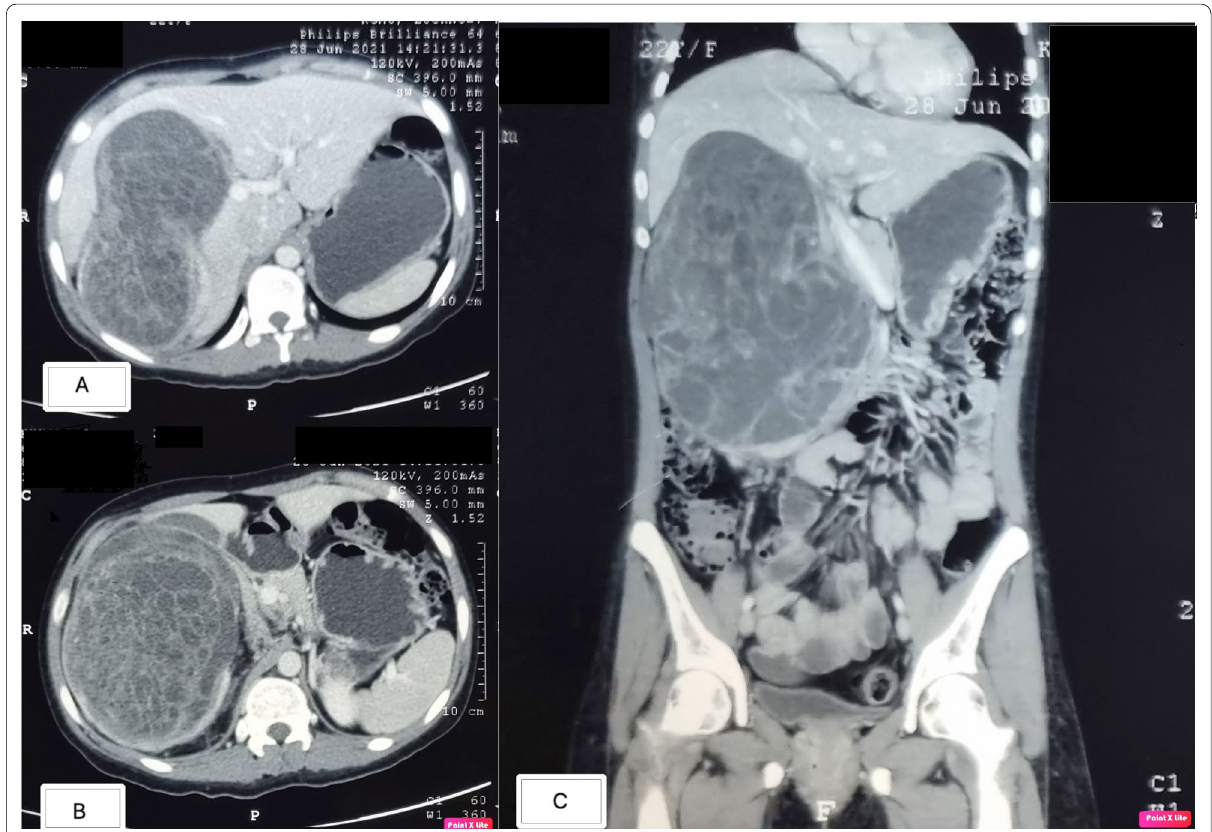
Fig. 1 A and B Cross section of the abdomen showing a large right renal mass pushing the liver upwards and to the left. C Coronal section of the abdomen showing a large right renal mass displacing the liver upwards and to the left. The inferior vena cave is also displaced to the